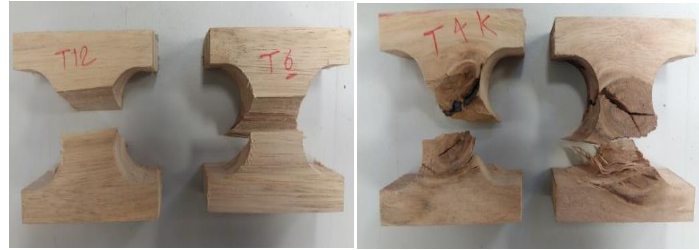
Figure 8. Failure modes of clear (left) and knotted (right) TPE samples.